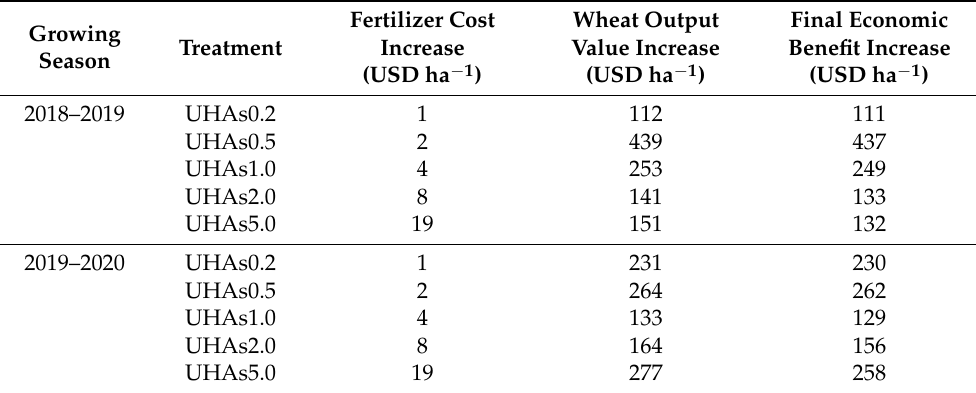
Table 6. Cost-benefit analysis for different HAU